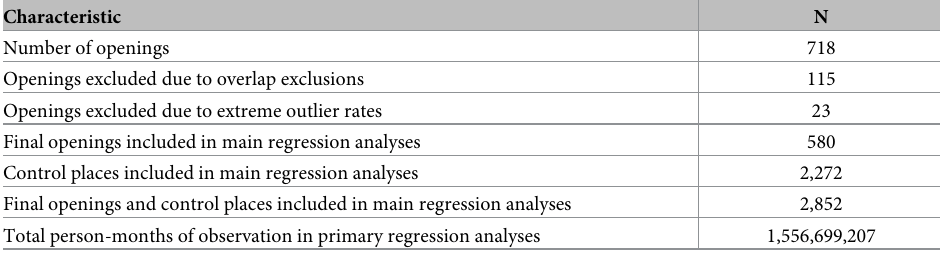
Table 1. Characteristics of firearm dealer openings and population exposure to these events.